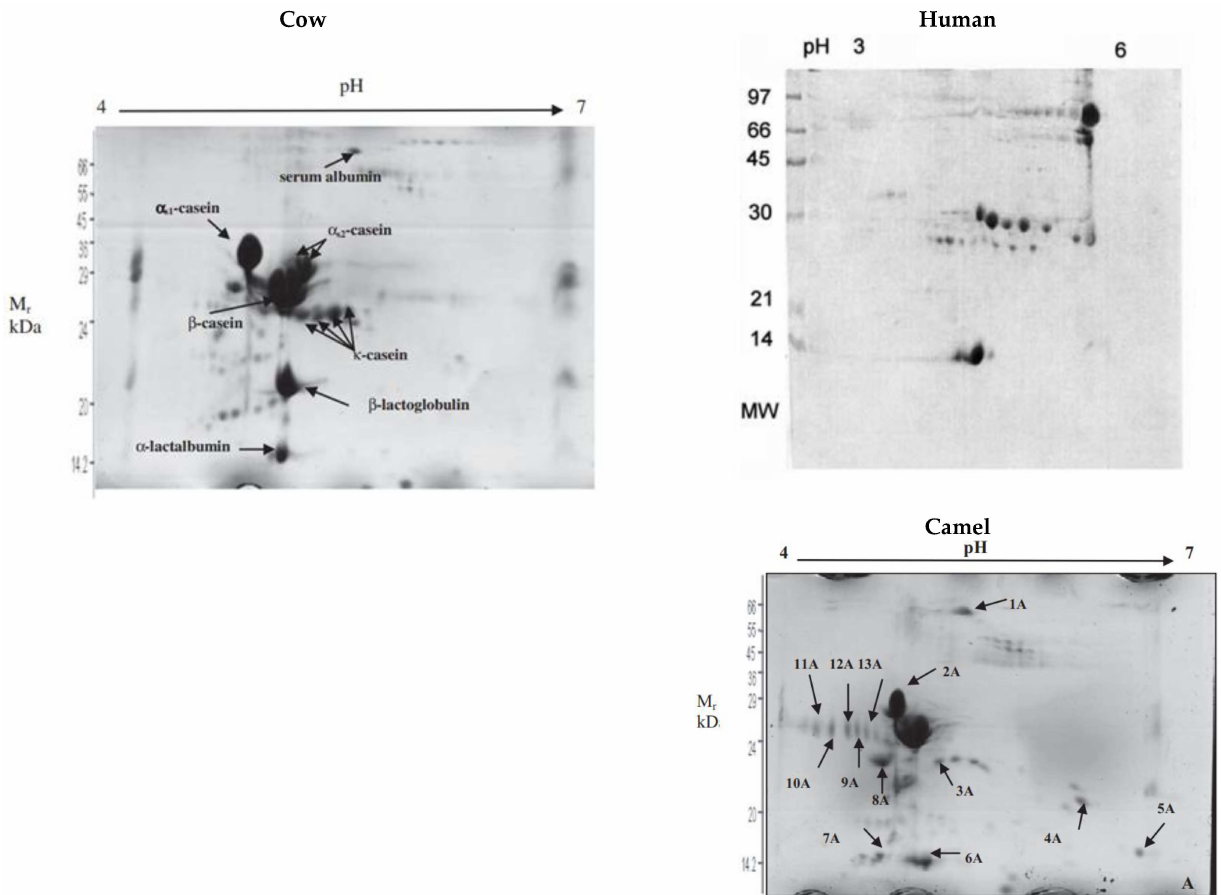
Figure 5. Two-dimensional gel electropherograms showing the different caseins in cow, human, and camel milks. For camel milk: spots 2A and 8A (aS1-casein), spots 3A, 4A, 5A, and 7A (b-casein), and spots 9A, 10A, 11A, 12A, and 13A (k-casein). Source: [65] eproduced with Creative Commons